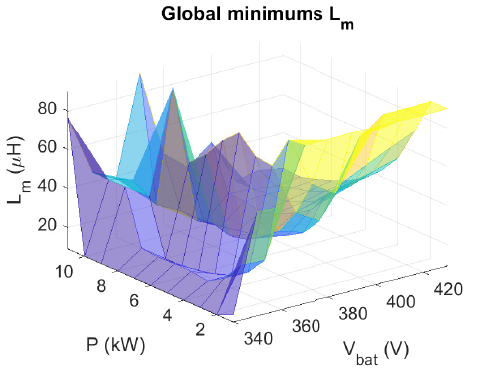
Figure 15. Global minimums of L m with respect to battery voltage and power variation.